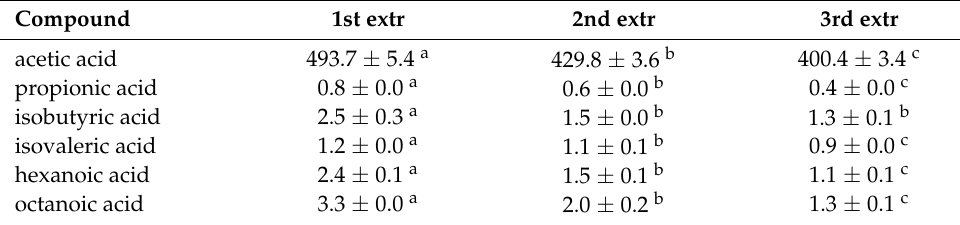
Table 1. Mean concentration (mg L − 1 ) ± standard deviation ( n = 2) obtained for each analyte from GC-FID analysis performing 1,2 or 3 subsequent ethyl ether extractions from a red wine sample (Nero D’Avola). Compound 1st extr 2nd extr 3rd